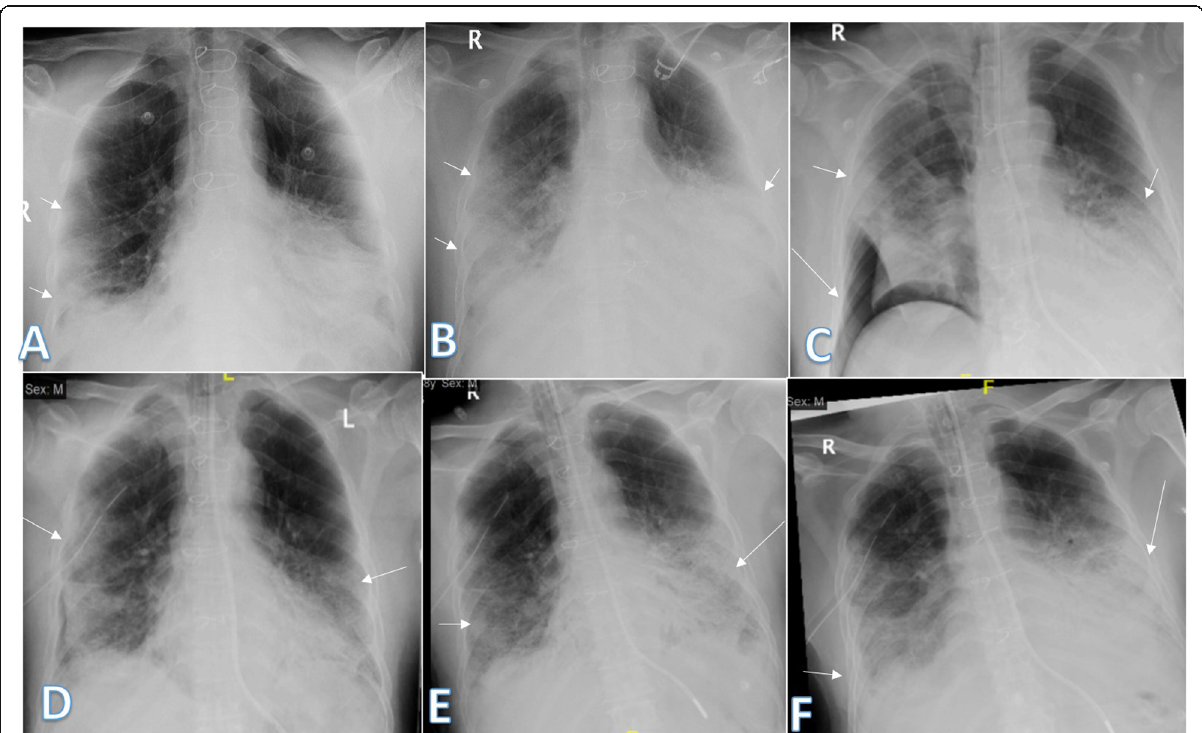
Fig. 17 68-year male was complaining of SOB and high fever. He had done previous CABD. Initial chest-ray ( a ) showed peripheral air space consolidation at the right mid and lower lung zones (arrows) with TSS 2, 4 days later ( b ), air space consolidation opacities increased on the right side and appeared at the lower zone of left lung with TSS 5 (3 on RT and 2 on LT). The patient deteriorated and was intubated. On the 6th day ( c ), he developed right side pneumothorax (long arrow) and ICT was inserted. Bilateral air space consolidation opacities (small arrows) of total severity score 5. On the 11th day ( d ), pneumothorax decreased with TSS still 5. On the 16th day ( e ), he developed mild left side pleural effusion (long arrow) with bilateral consolidation opacities of TSS 6. On the 23rd ( f ), he developed mild right pleural effusion (arrow) with TSS 6. The patient died 1 day